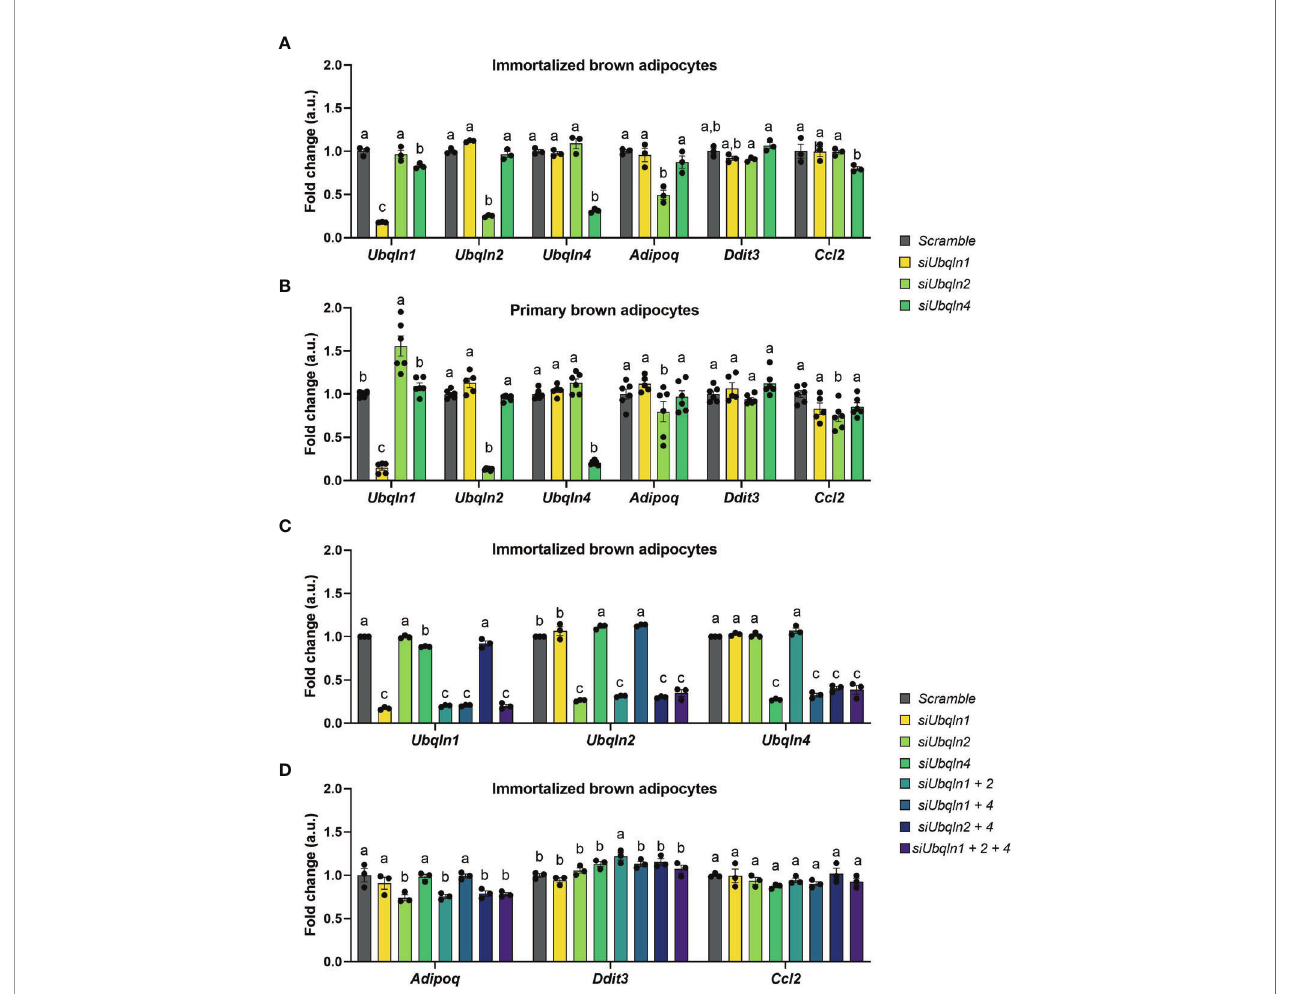
FIGURE 2 | Silencing of Ubqln1, 2 and 4 in brown adipocytes does not cause ER stress or in fl ammation. Ubiquilins were silenced by siRNA-mediated knockdown in imBAT and primary brown adipocytes. Relative gene expression measured by qPCR in: (A) , imBAT ( n = 3 technical replicates). (B) , primary brown adipocytes ( n = 5-6 technical replicates from 2 independent experiments). (C, D), imBAT (n = 3 technical replicates). Throughout, data are mean ± SEM. Statistical testing was done by two-way ANOVA with Bonferroni post-hoc test. Different small letters indicate differences in mean compared to Scramble with at least P adj <